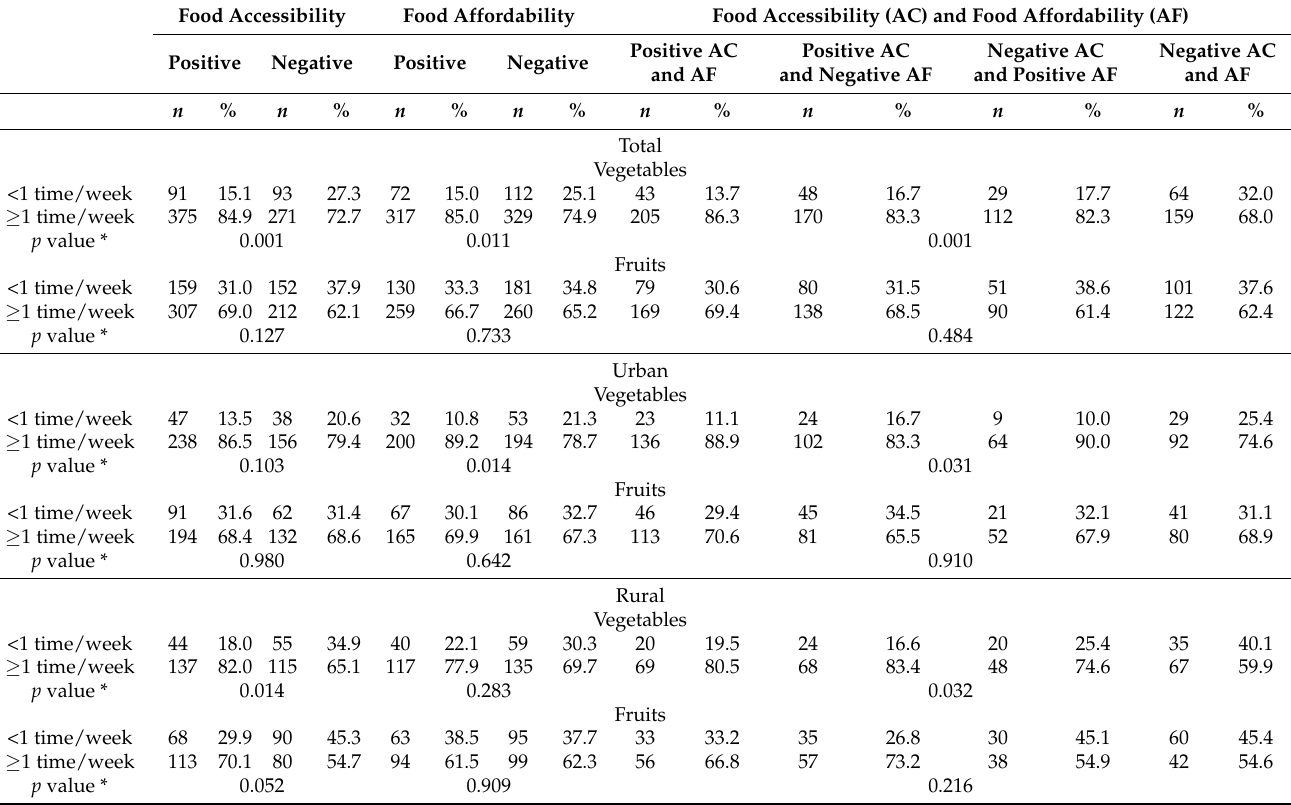
Table 3. The relationship of perceived food environment with vegetable and fruit